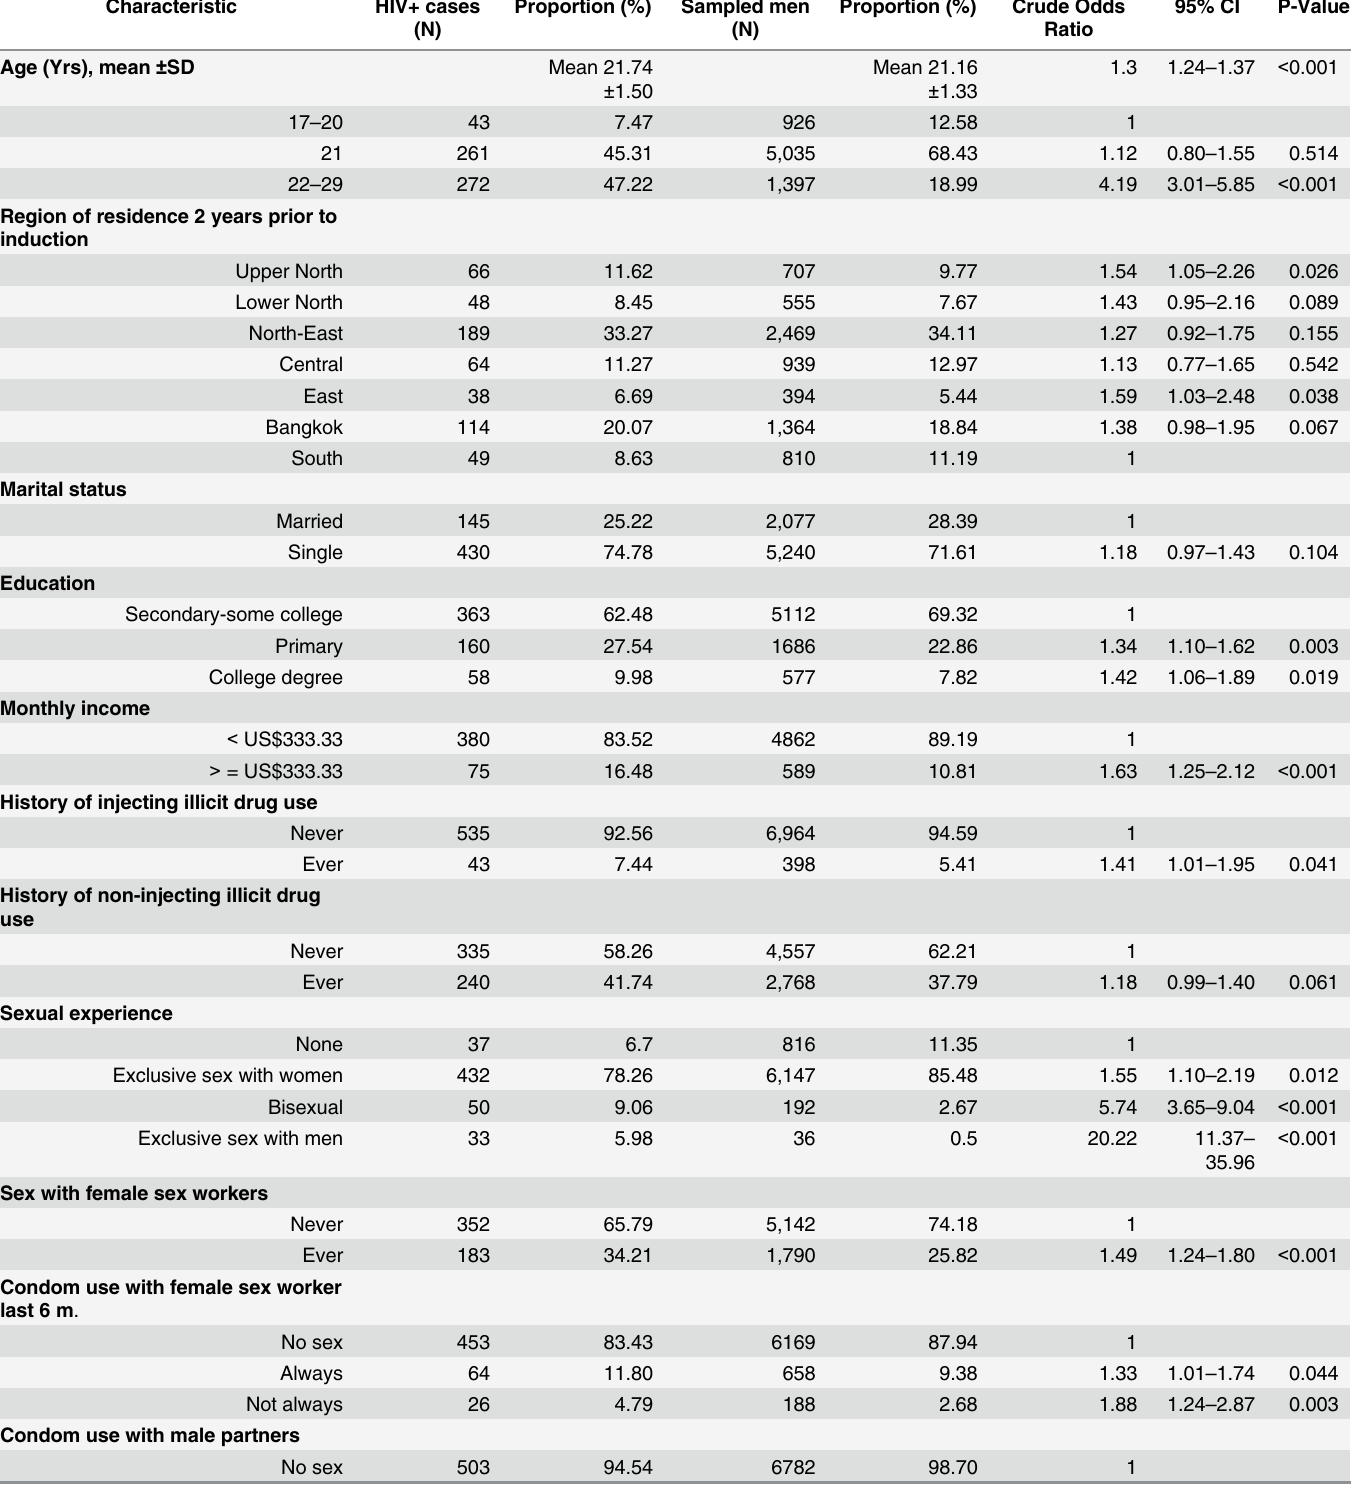
Table 3. Characteristics of study participants and associations with HIV